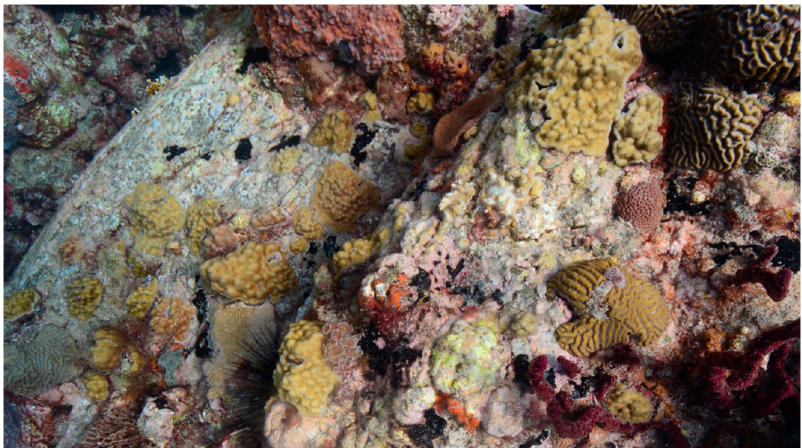
Figure 7. Portion of a quadrat photo from the ‘Seaview’ site on Carriacou in 2014. P. astreoides is abundant, with many colonies growing in close proximity to one another.